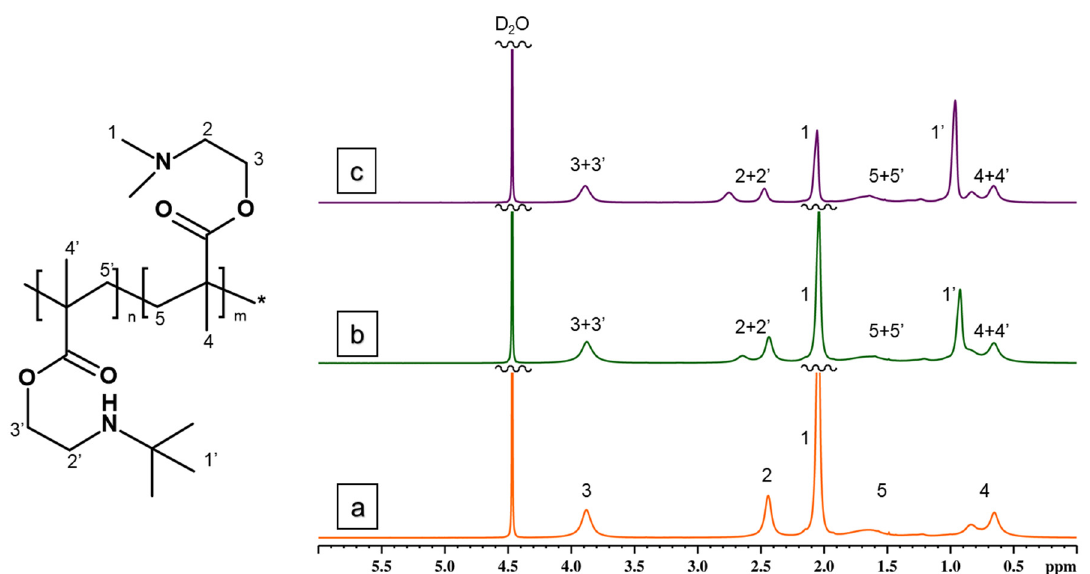
Figure 4. High-resolution 1 H NMR spectra of ( a ) poly[2-(dimethylamino)ethyl methacrylate], ( b ) poly[2-(dimethylamino)ethyl methacrylate- co- 2-( tert -butylamino)ethyl methacrylate] (0.75/0.25 mol/mol), and ( c ) poly[2-(dimethylamino)ethyl methacrylate- co- 2-( tert -butylamino)ethyl methacrylate] (0.5/0.5 mol/mol) measured in D 2 O at 25 ◦ C. Resonance assignment of PDMAEMA and PDMAEMA-TBAEMA copolymers is shown in the spectra.